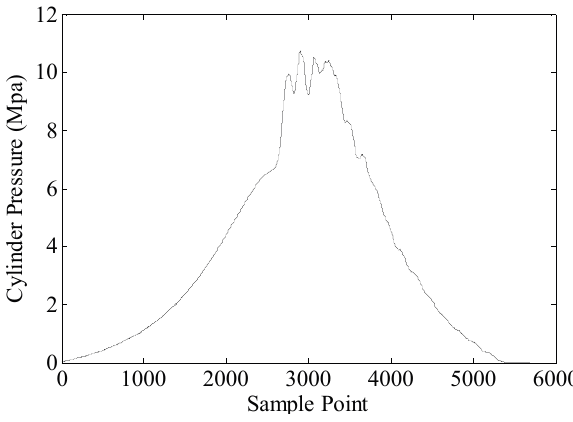
Figure 3. Combustion segment from a cylinder pressure